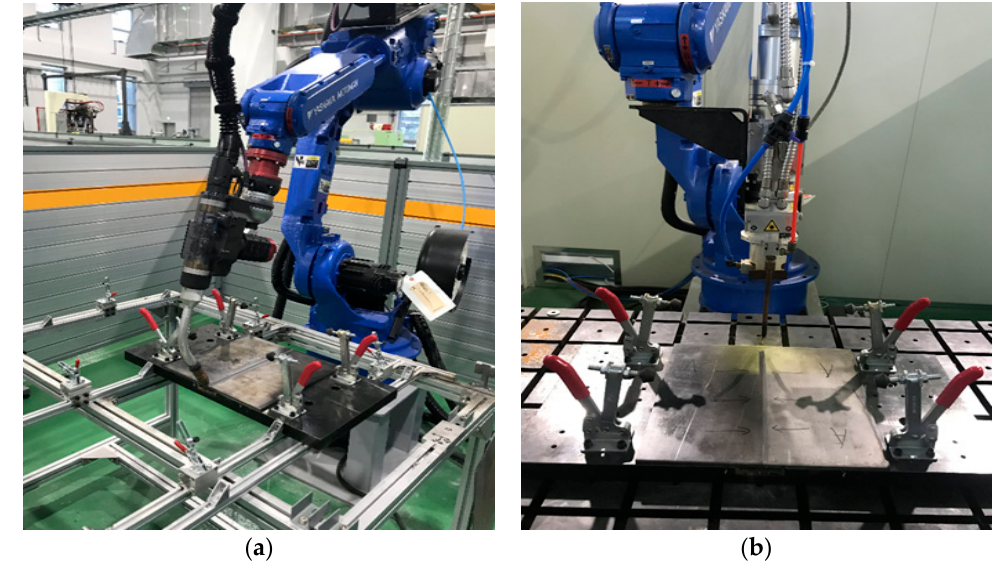
Figure 2. Welding equipment. ( a ) FCAW equipment. ( b ) LBW equipment.